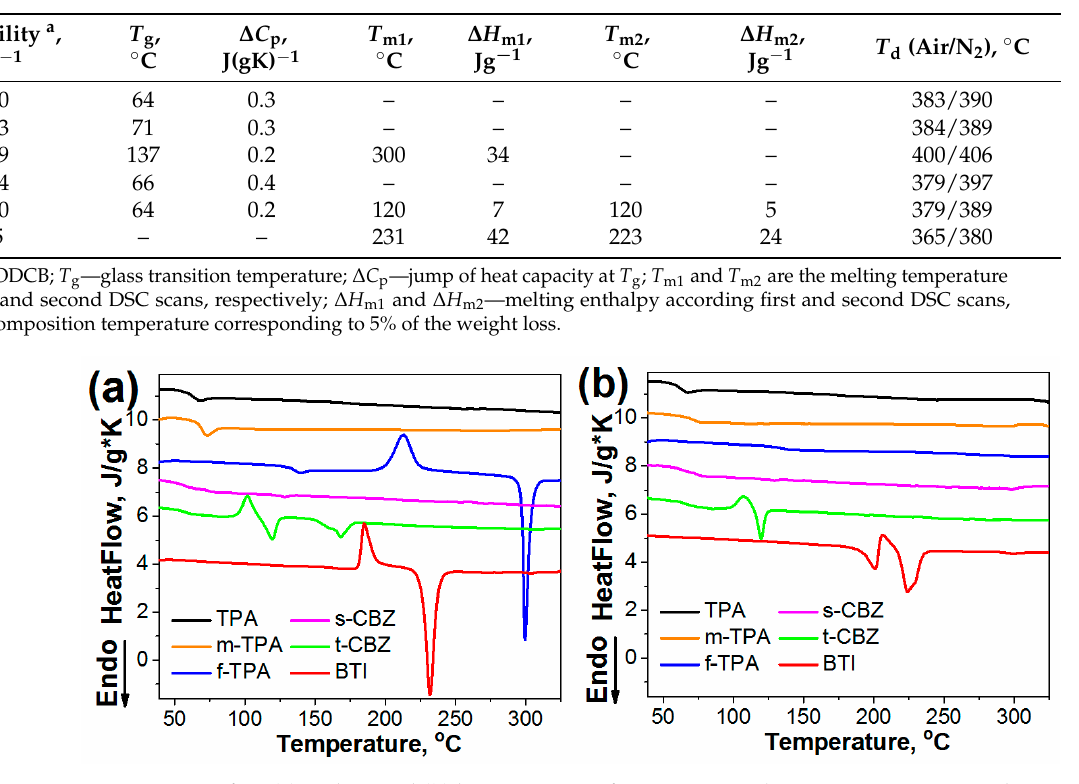
Figure 4. DSC first ( a ) and second ( b ) heating scans of TPA , m-TPA , f-TPA , s-CBZ , t-CBZ and BTI . The solubility of the molecules was measured in o -dichlorobenzene (ODCB) solu- tions (Table 1). The solubility of the s-CBZ and t-CBZ molecules that have